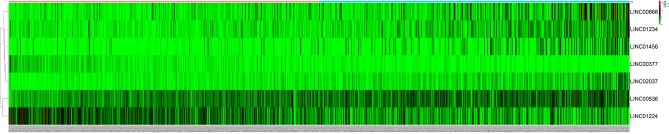
The heatmap of 7 independent breast cancer-related prognostic lncRNAs in the model. The color from green to red indicates a trend from low to high expression.